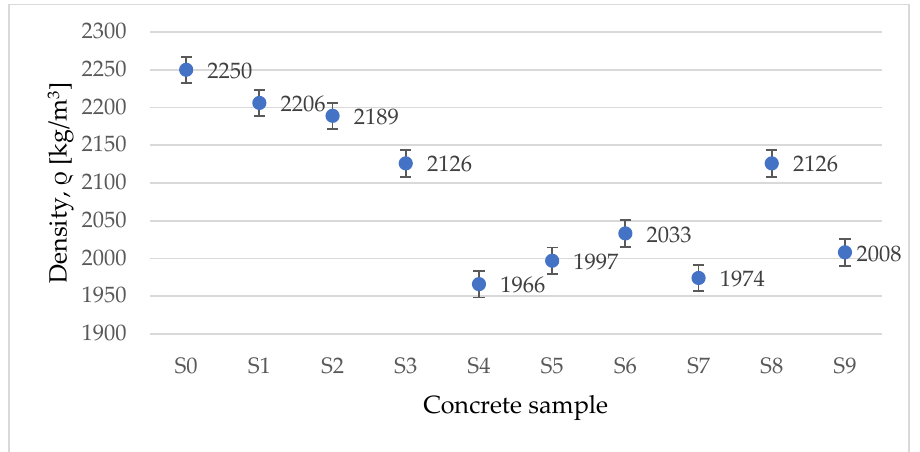
Figure 6. Variation of density for tested concrete samples.